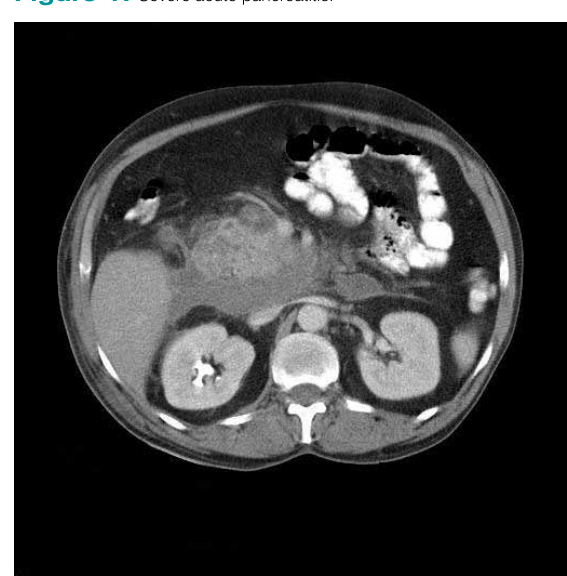
Figure 1. Severe acute pancreatitis.